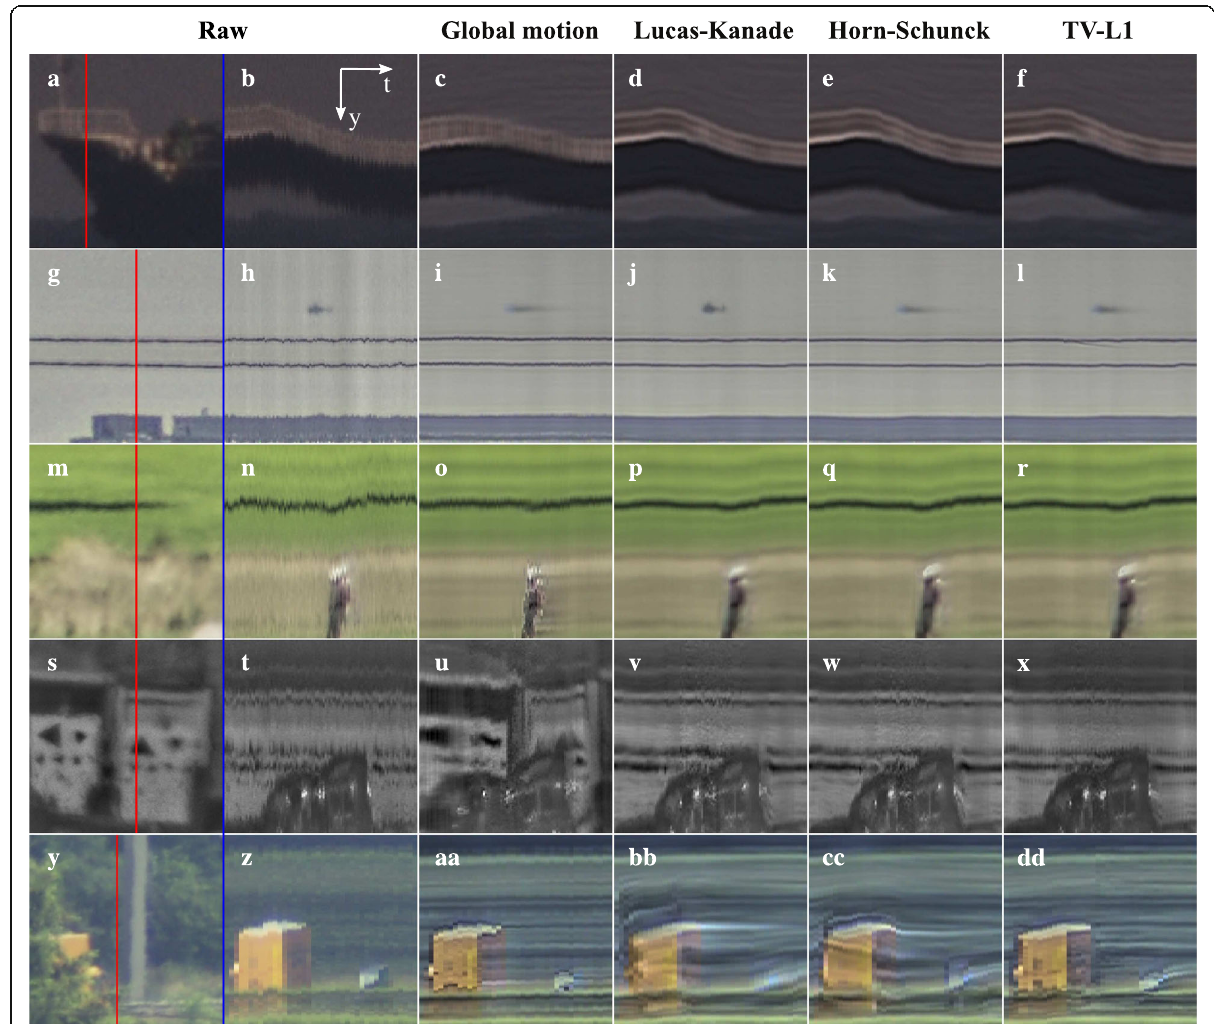
Fig. 12 Temporal cross-sections of the different motion estimation methods to each of the datasets in this article ( b - f , h - l , n - r , t - x , z -dd). The leftmost column ( a , g m , s , y ) shows region of interest in the first frame of each temporal cross section. The red lines indicate the vertical image lines which for which temporal cross-sections are shown in the other